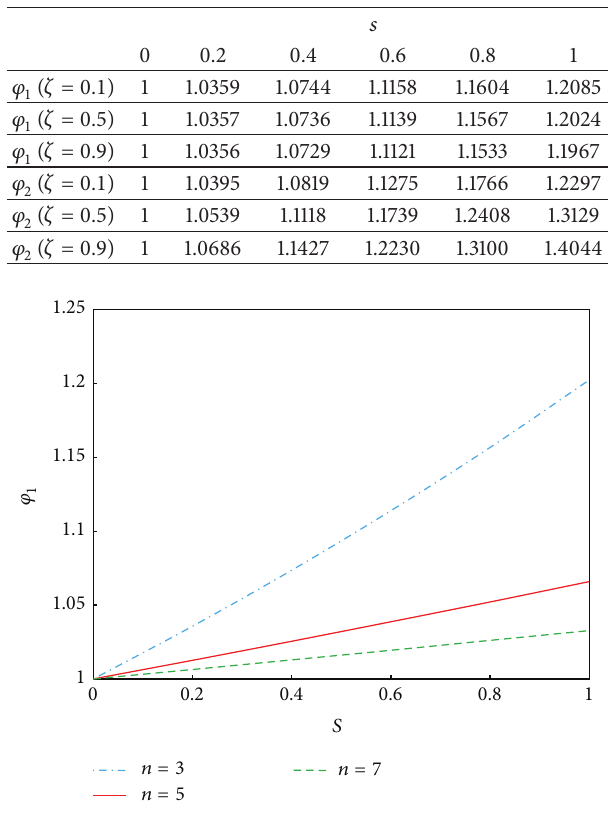
Figure 6: Relationship between ratio 𝜑 1 and dimensionless param- eter 𝑠 for different mode number 𝑛 .